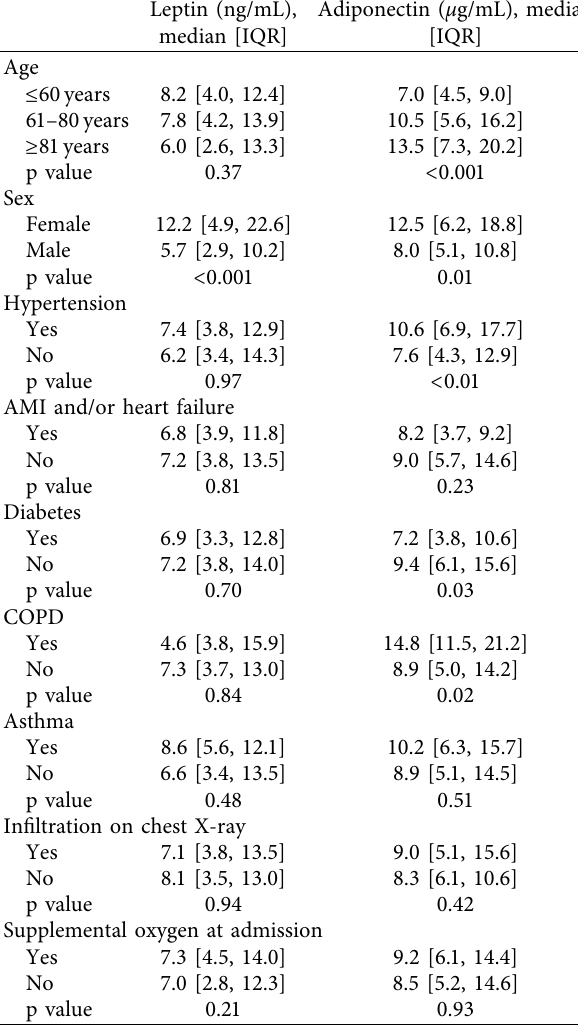
Table 2: Levels of circulating leptin and adiponectin in diferent subgroups of patients hospitalized with